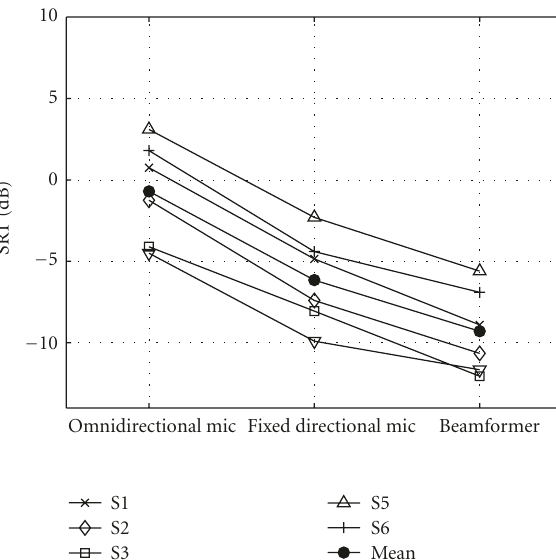
Figure 10: Speech reception thresholds (SRT) of six cochlear implant users for noise arriving from the side contralateral to the behind-the-ear microphone